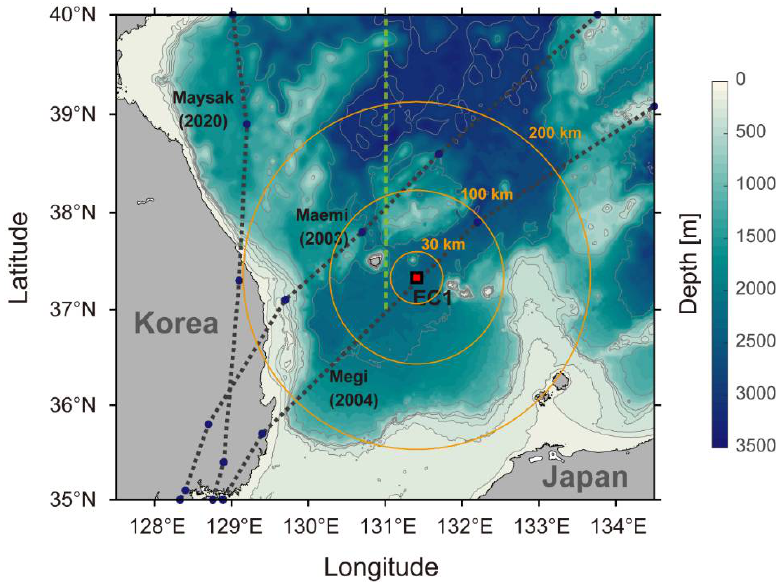
Figure 2. Location of subsurface mooring EC1 (red square) with bathymetry (colour) in the south- western East Sea, off the east coast of Korea. Green dotted line indicates meridional line where sea surface wind data were extracted. Black dashed lines indicate trajectories of typhoon Maemi in 2003, Megi in 2004, and Maysak in 2020. The yellow circles indicate radii of 30, 100 and 200 km centred at EC1, respectively.